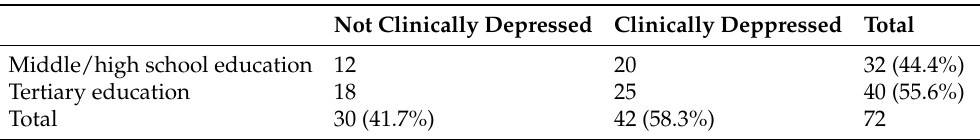
Table 4. Table of observed frequencies of maternal education groups by clinical depression diagnosis